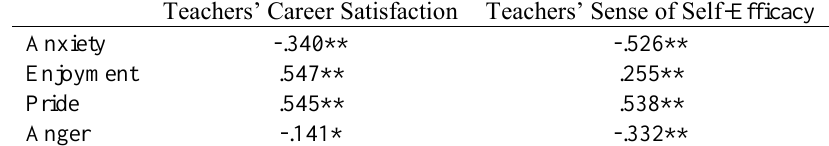
Convergent Validity (Japanese Sample)